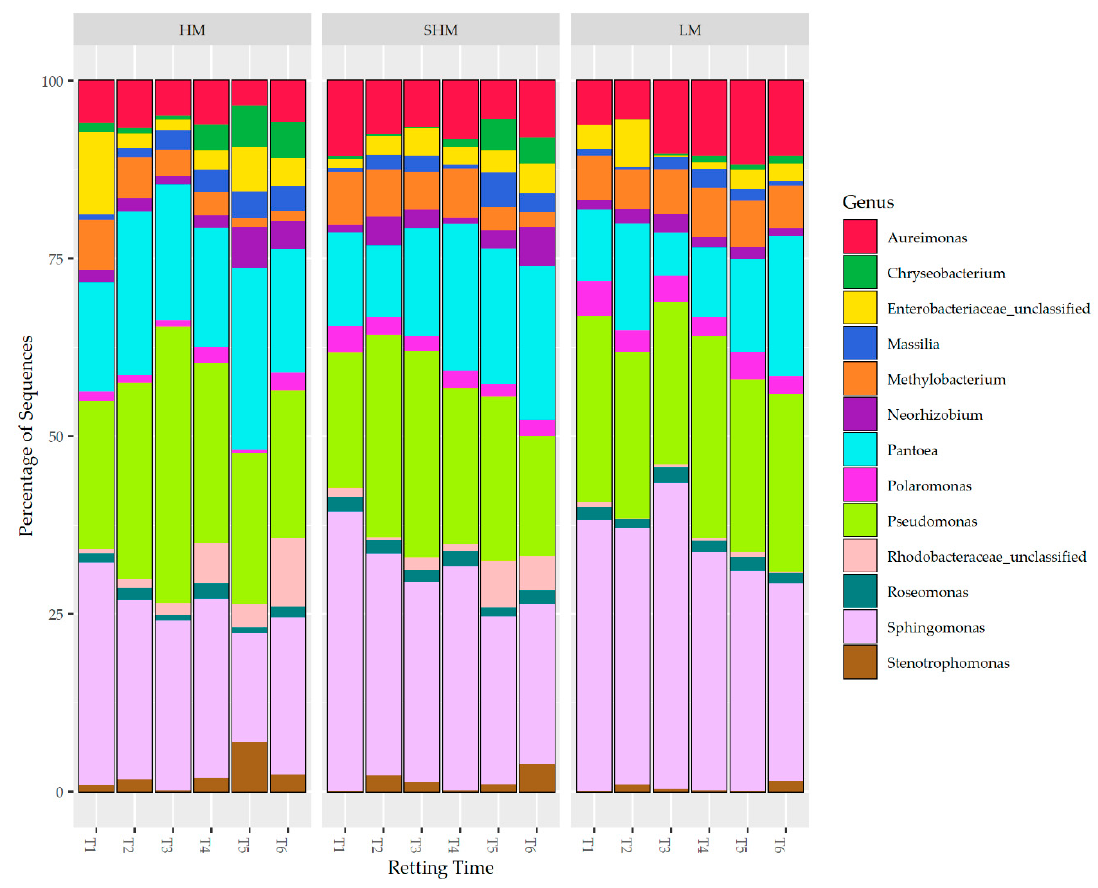
Figure 3. Relative abundance of genera composed of the 20 most abundant OTUs, according to treatment over time.